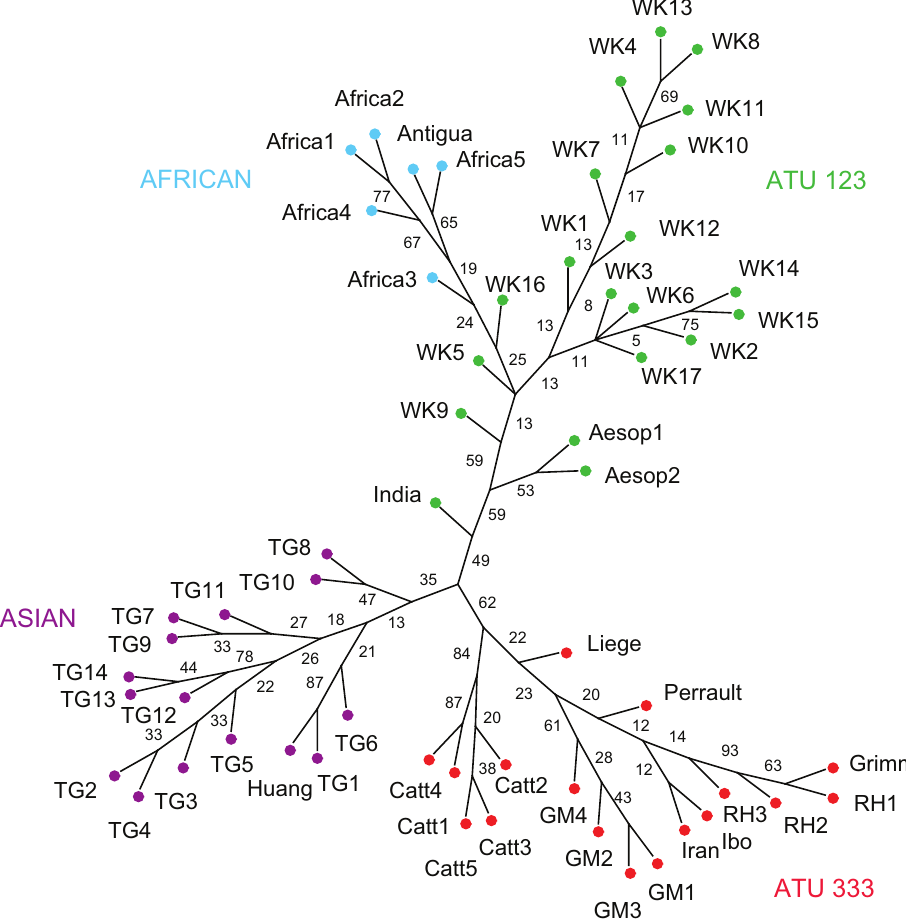
Figure 2. Majority-rules consensus of the most parsimonious trees returned by the cladistic analysis of the tales. Major groupings are labelled by region or ATU international type and indicated by the coloured nodes. Sub-types are indicated in the taxa labels (RH = Little Red Riding Hood; GM = Story of Grandmother; Catt = Catterinella; WK = The Wolf and the Kids; TG = Tiger Grandmother). Variants by particular authors, or from countries/ethnic groups that are discussed in the text have individual labels. Numbers beside the edges represent the level of support for individual clades returned by the bootstrap analysis.